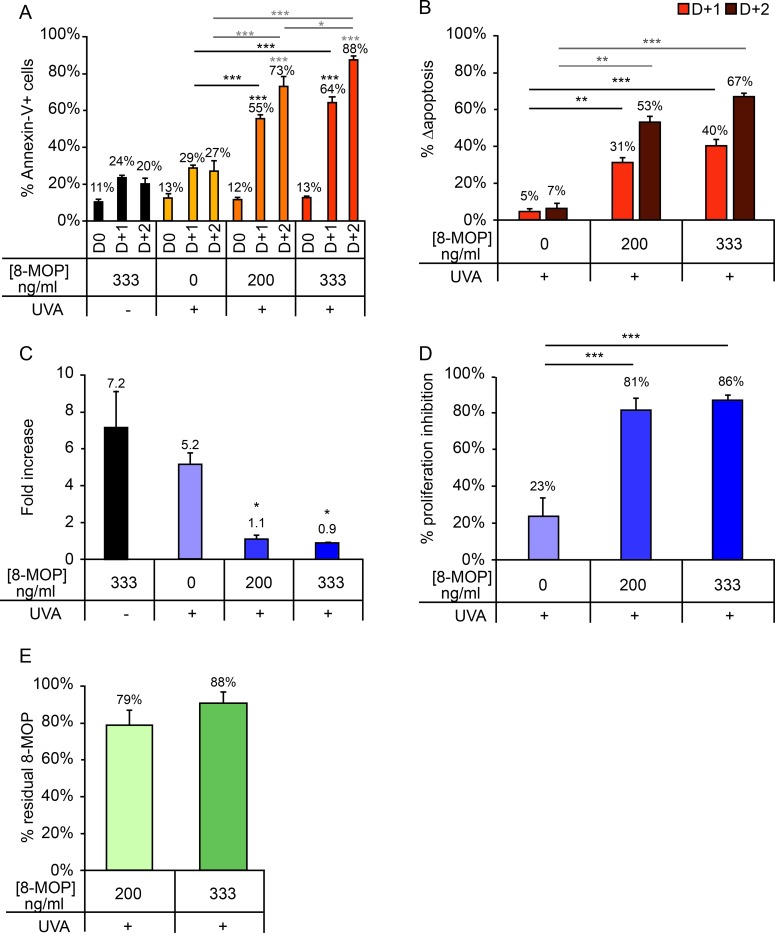
Impact of 8-MOP concentration (0 ng/ml, 200 ng/ml, or 300 ng/ml) on cellular response after a 2 J/cm2 UVA dose.(A) Percentage of Annexin-V+ cells measured daily up to 2 days after irradiation. (B) Δapoptosis determined on days 1 and 2 post-irradiation. (C) Fold increase on day 3 post-irradiation relative to day 0. (D) Proliferation inhibition percentage, calculated as the percentage decrease in proliferation in irradiated versus control samples. (E) Residual 8-MOP remaining in the irradiation container after treatment, expressed as a percentage of the pre-irradiation 8-MOP concentration. For clarity, only statistically significant results are shown.*p<0.05; **p<0.01; ***p<0.001. Significant differences with respect to the control (UVA -) are indicated with an asterisk above the relevant bar, while comparisons between irradiated samples are indicated with an asterisk over a line linking the relevant bars. For Annexin-V+ cells (A) and Δapoptosis (B), comparisons performed on days 1 and 2 post-irradiation are indicated in black and gray, respectively.